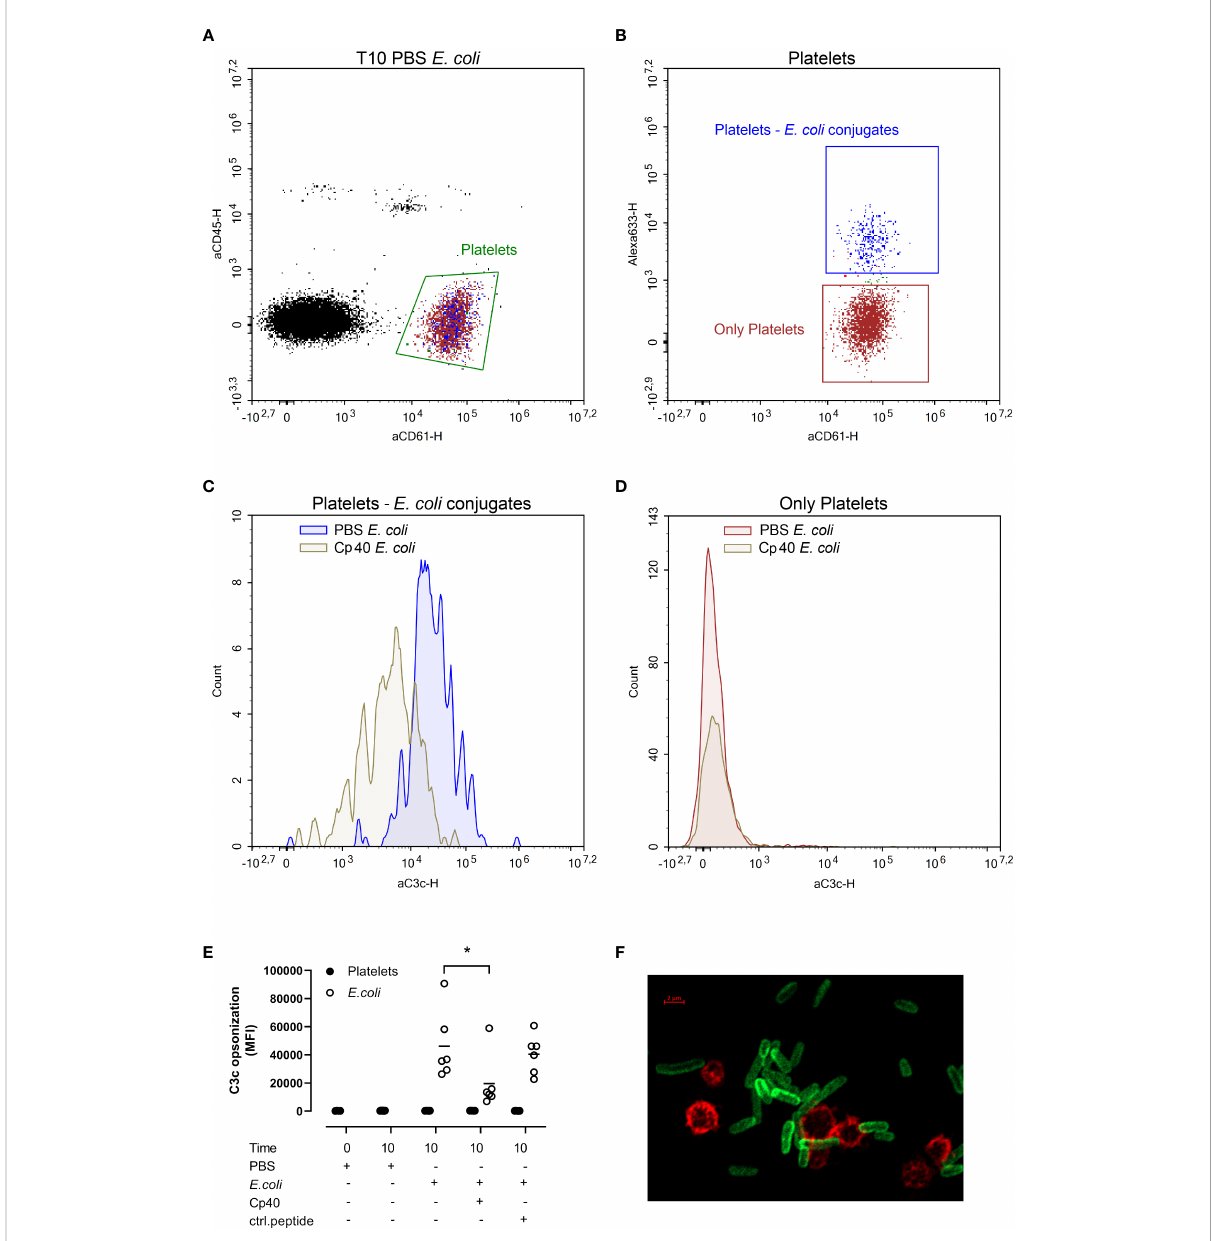
FIGURE 3 The C3b opsonization of platelets and Escherichia coli ( E. coli 1 x 10 9 /mL) were measured by fl ow cytometry after performing the human whole blood model. E. coli was labeled with Alexa Fluor 633, platelets were detected by BV605-labeled anti-CD61-antibody, leukocytes by V450- labeled anti-CD45-antibody, and C3b opsonization was measured using a FITC-labeled anti-C3c-antibody. The blood was incubated at 37 °C for 10 minutes after adding phosphate-buffered saline (PBS) control, compstatin (Cp40, 20 µM) or control peptide (20 µM), and PBS or E. coli as activators. The population of all platelets, both platelets alone and in conjugation with E. coli , was gated in an aCD45-aCD61 plot (A) . The Alexa 633-aCD61 plot was used to separate the platelets alone (red) and the platelets in conjugation with E. coli (blue) (B) . Histogram showing the C3b opsonization of platelet- E. coli conjugates; the sample without inhibition in blue, the sample with compstatin in gray (C) . Histogram showing the C3b opsonization of the platelets alone; the sample without inhibition in red and the sample added compstatin in gray (D) . The plots (A-D) were from one of the six donors and were representative of the other donors which showed the same pattern. E. coli -induced C3b opsonization is shown in a dot plot diagram (E) , with data for platelets alone (closed circles) and data for platelets together with E. coli (open circles) (n = 6). Results are given in mean fl uorescence (MFI) for C3c, the mean is reported as lines in the fi gure. *; p < 0.05 analyzed using one- way ANOVA repeated measurements, and Dunnett ’ s multiple comparisons test, comparing E. coli -activated samples with and without inhibitors or control. A confocal super-resolution image of platelets interacting with C3b opsonized E. coli in whole blood (F) . Platelets were detected with a BV605-labeled anti-CD61 antibody (red), and C3b was detected with a FITC-labeled anti-C3c antibody